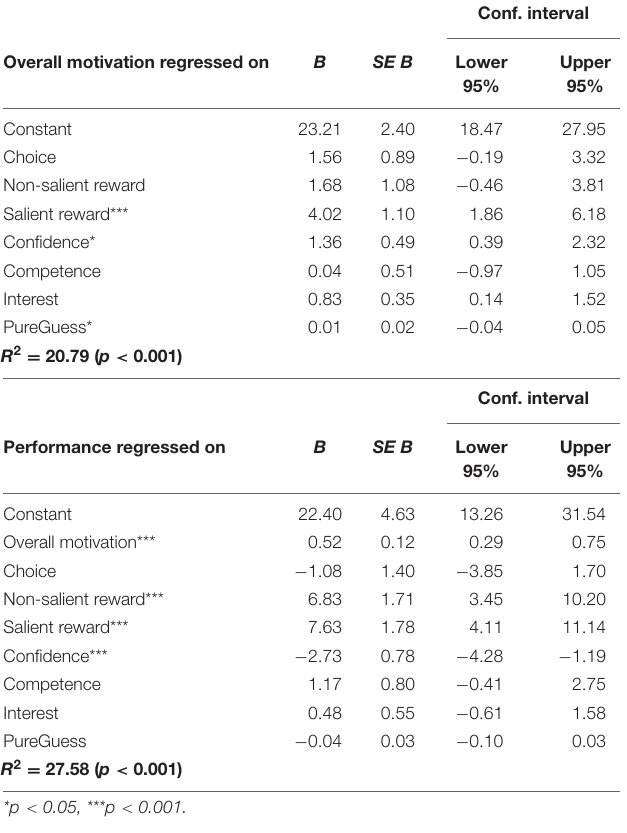
TABLE 3 | OLS regression bias-corrected analysis of choice effect on overall motivation and performance.